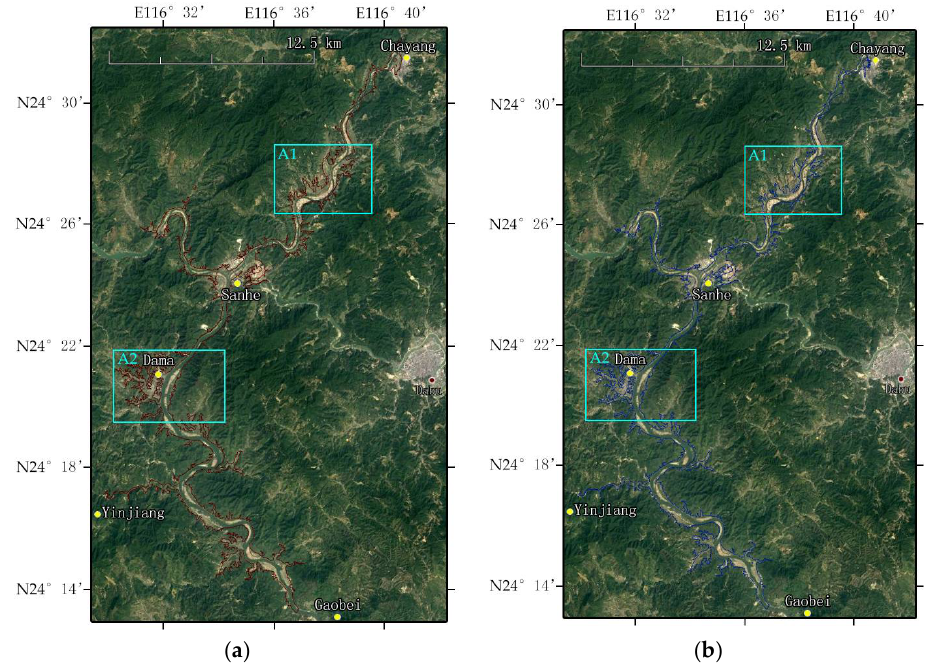
Figure 9. The flood inundation range of different return periods. ( a ) The flood inundation range of HQ 100 ; and, ( b ) The flood inundation range of HQ 50 .